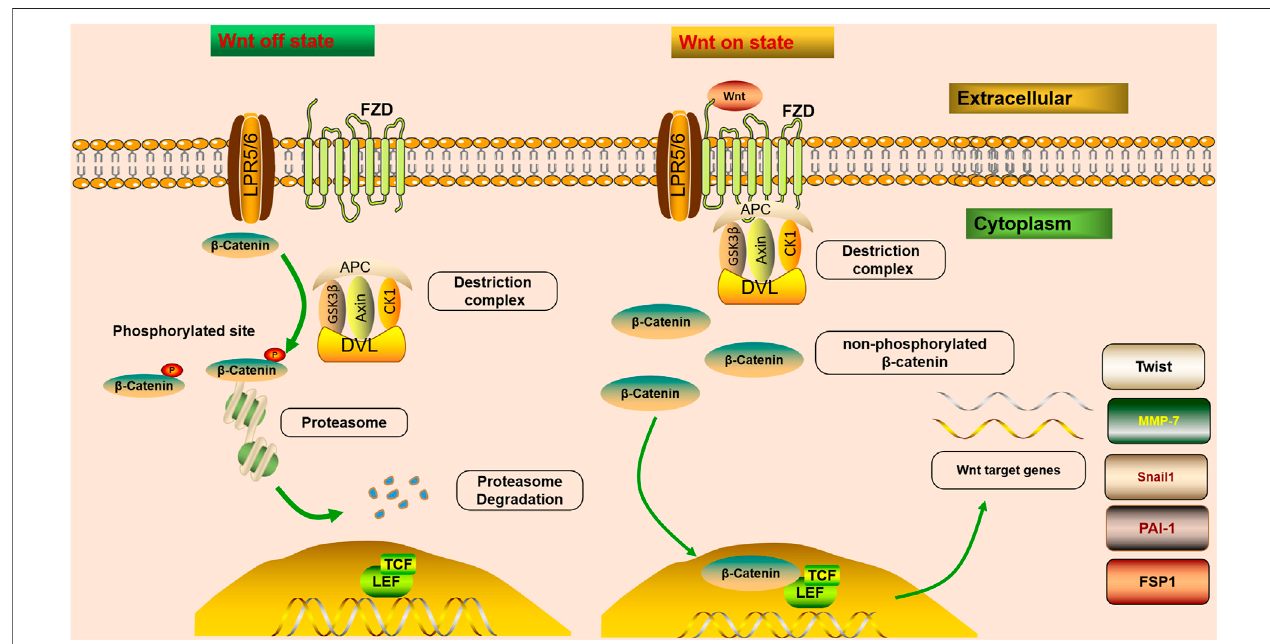
FIGURE1| Wnt/ β -cateninsignalingisofforonstate.Insteady-state, β -cateninisinactivatedbya “ destructioncomplex, ” andphosphorylation,ubiquitinylated,and degraded of β -catenin ismediatedby theprotein complex. Wnton state; Wntmolecules transmit theintracellularsignal in theintracellularmatrix through interactingwith FZD receptors and LRP5/6. After that, the interaction triggers the intracellular signal cascade and promotes the accumulation of non-phosphorylated β -catenin, which translocates into the nucleus, and cooperates with TCF/LEF to trigger the transcription of Wnt target genes. Once Wnt ligands bind to co-receptors on cytomembrane, the combination of FZD and DVL could provide a recruitment platform for the β -catenin destruction. Wnt/ β -catenin controls the expression of various downstream mediators implicated in renal fi brosis, such as Snail1, MMP-7, PAI-1, Twist, and FSP1.